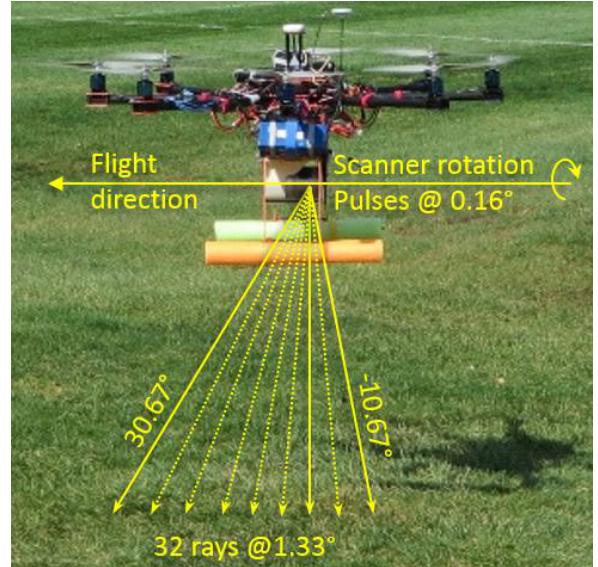
Figure 3. Scanning principle of a horizontally